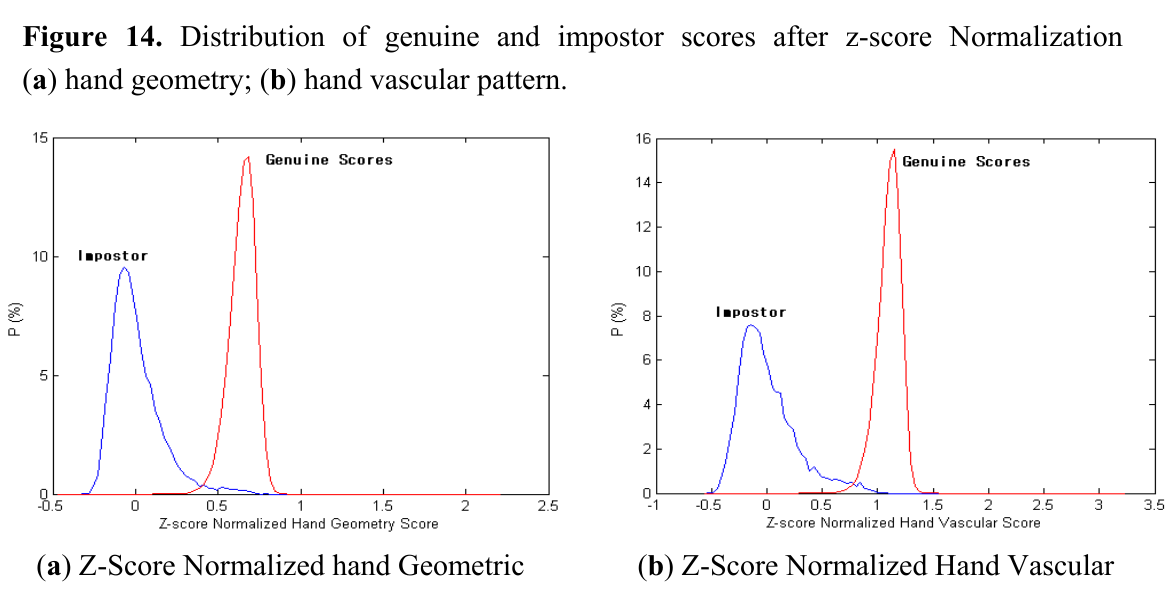
( a ) Z-Score Normalized hand Geometric ( b ) Z-Score Normalized Hand